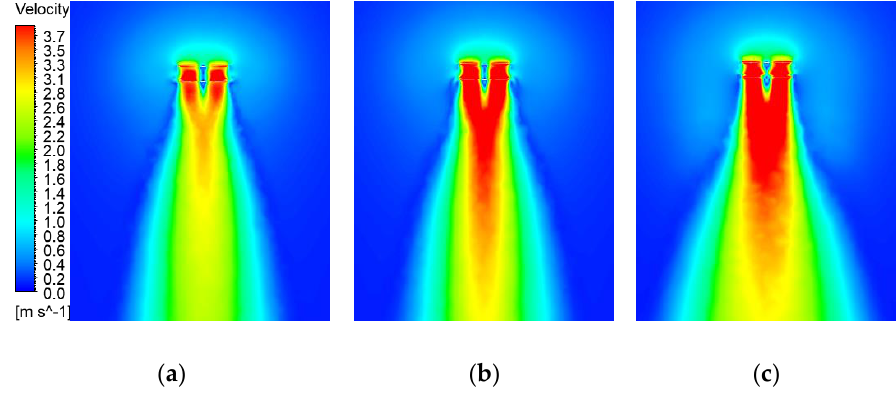
Figure 10. Velocity contours at Re = 0.89 × 10 5 . ( a ) i = 0.71; ( b ) i = 0.63; ( c ) i =